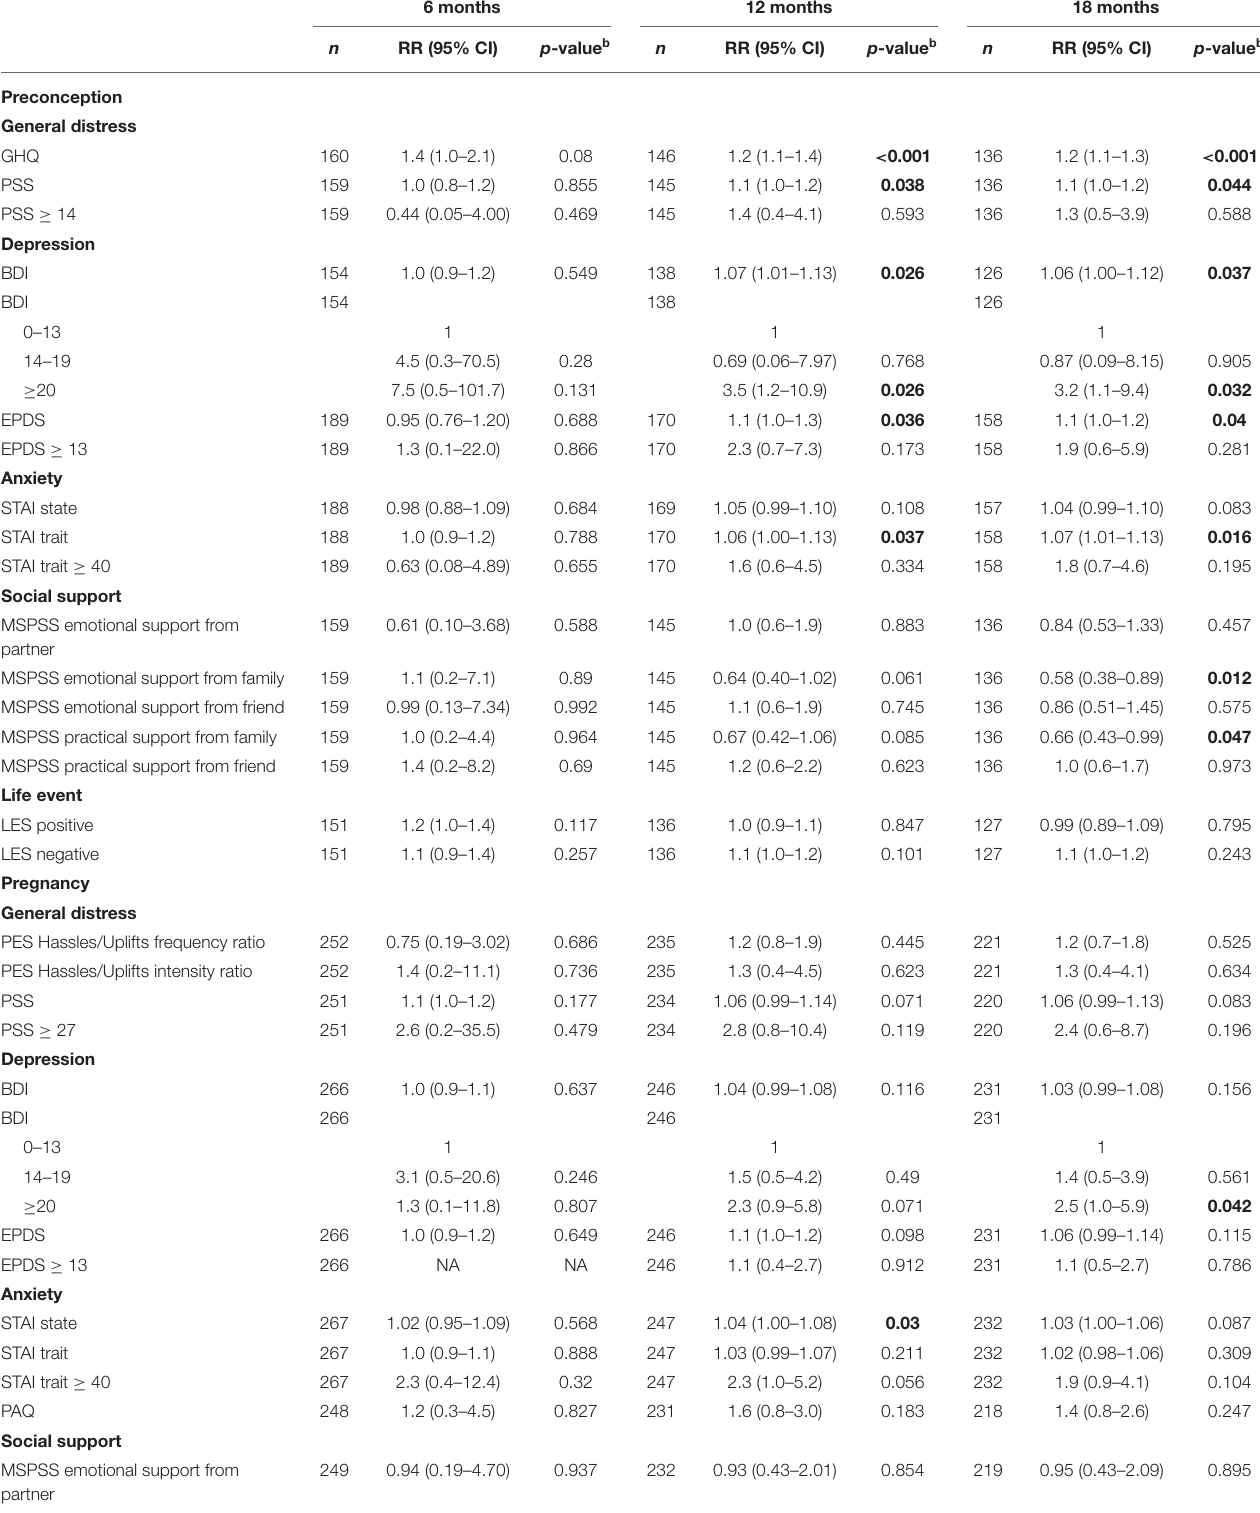
TABLE 2 | Multivariate poisson regression of wheeze by 6, 12, and 18